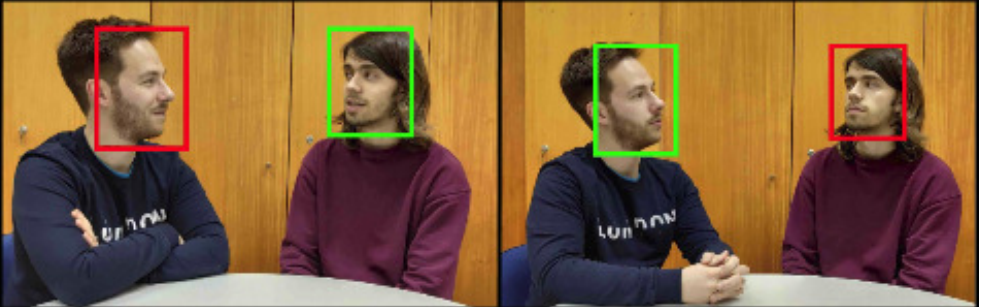
Figure 1. Exemplary output of an multi-speaker active speaker detection (ASD) system where an intervening speaker is denoted in green and a passive speaker is encircled in